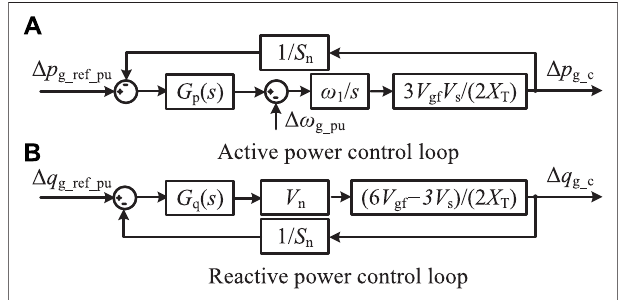
FIGURE 3 | Block diagrams of the simpli fi ed active and reactive power control loops.